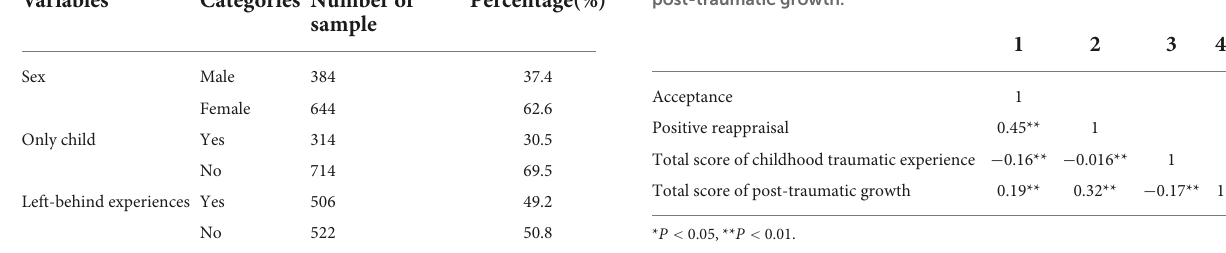
experience, acceptance, positive reappraisal and post-traumatic growth.